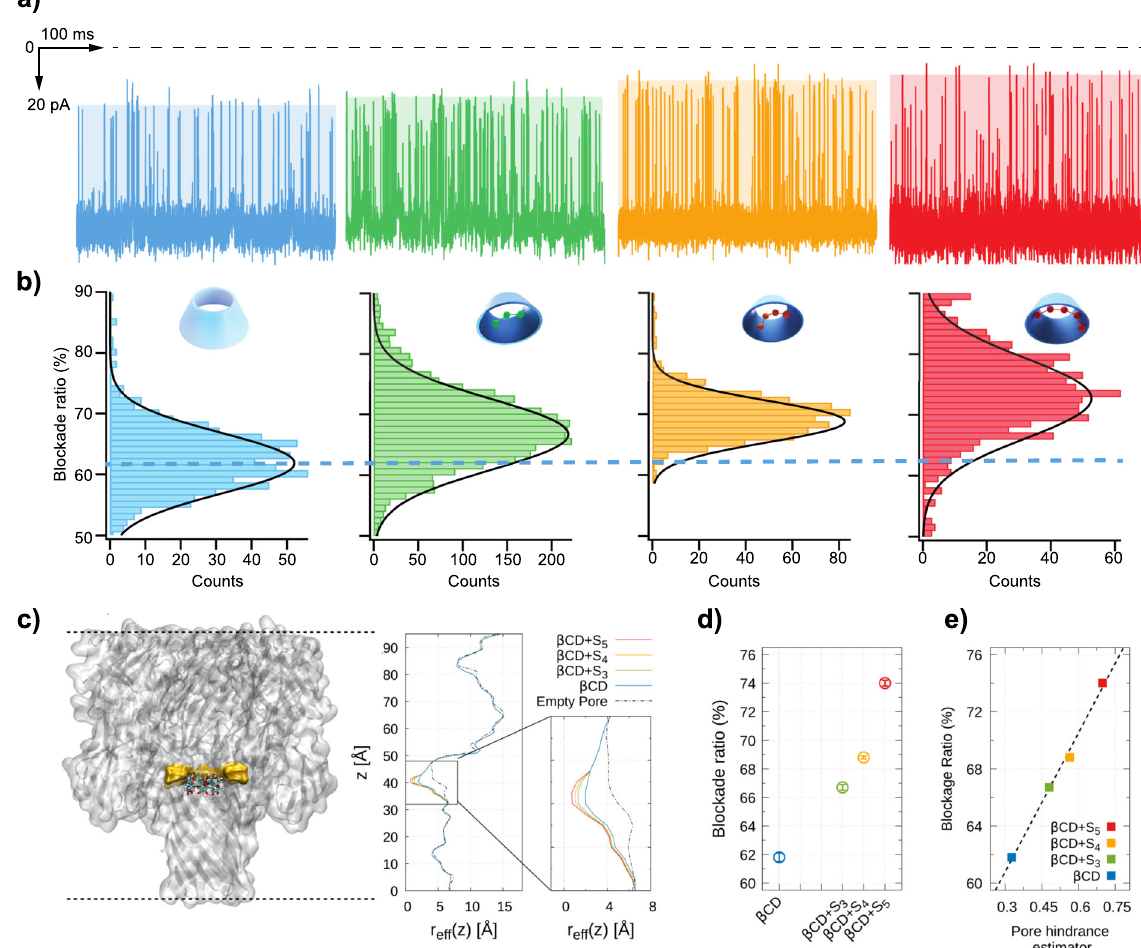
Fig. 5 Discrimination of Na 2 S x / β -cyclodextrin complexes. a Part of current versus time traces of an α -HL pore at − 100 mV, in the presence of 1 mM β -cyclodextrin (blue), Na β -cyclodextrin (green), Na β -cyclodextrin (orange), Na β -cyclodextrin (red). All experiments are independent (6 in 2 S 3 / 2 S 4 / 2 S 5 / total), performed in 1 M NaCl, 25 mM NaHCO 3 pH 10, at − 100 mV, in an Argon fi lled glovebox. b Histograms of blockade ratio for β -cyclodextrin (blue, 61.8 ± 0.3%), Na 2 S 3 / β -cyclodextrin (green, 66.7 ± 0.2%), Na 2 S 4 / β -cyclodextrin (orange, 68.8 ± 0.1%), Na 2 S 5 / β -cyclodextrin (red, 74.0± 0.3%). c Accessible volume estimation from Molecular Dynamics simulations. α -HL constriction is highlighted in yellow, while β -cyclodextrin atoms are represented as balls-and-sticks. The plot reports the radius of the effective pore section available for ion passage. The effective pore section in the presence of β -cyclodextrin and Na 2 S x / β -cyclodextrin are represented using the same color code of the other panels. d Experimental current blockades. Error bars are the con fi dence intervals of the average estimator (see “ Methods ” section). e Nanopore hindrance estimator calculated from atomistic model. Panel ( c ) was made using the VMD